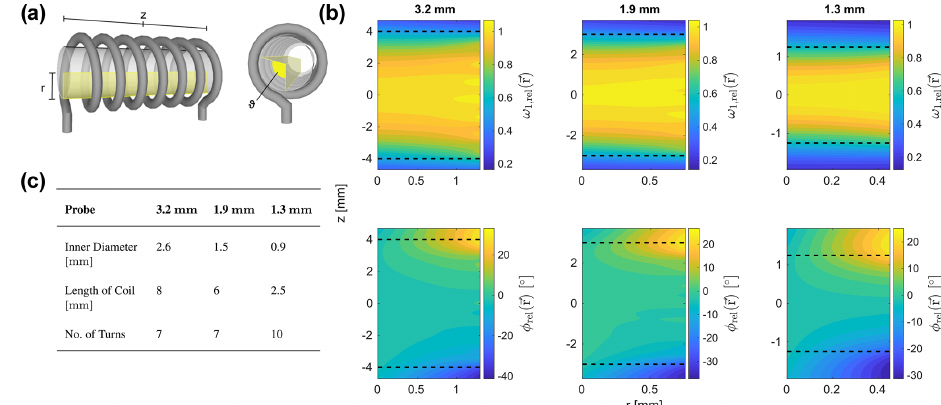
Figure 1. (a) Coil geometry of a typical 3.2mm Bruker MAS probe. The position within the sample space is indicated by the cylindrical coordinates r , z , and ϑ . (b) Spatial rf field distributions for typical probe designs with MAS rotors of 3.2, 1.9, and 1.3mm outer diameter at a frequency of 600MHz. Relative rf amplitudes ω rel and phases φ rel are shown as a function of the position within the active sample volume for ϑ = 90 ◦ . The length and position of the solenoid coil is indicated by dashed lines. (c) Parameters of coil geometries of the 3.2, 1.9, and 1.3mm MAS probes considered in this work. The z values were sampled in steps of 0.05mm for all three probes. The r values were sampled in steps of 0.05mm for the 3.2 and the 1.9mm probes and in steps of 0.025mm for the 1.3mm probe. The sample volume considered in the numerical simulations and Floquet analyses presented in Sect. 5 was restricted to the length of the coil.